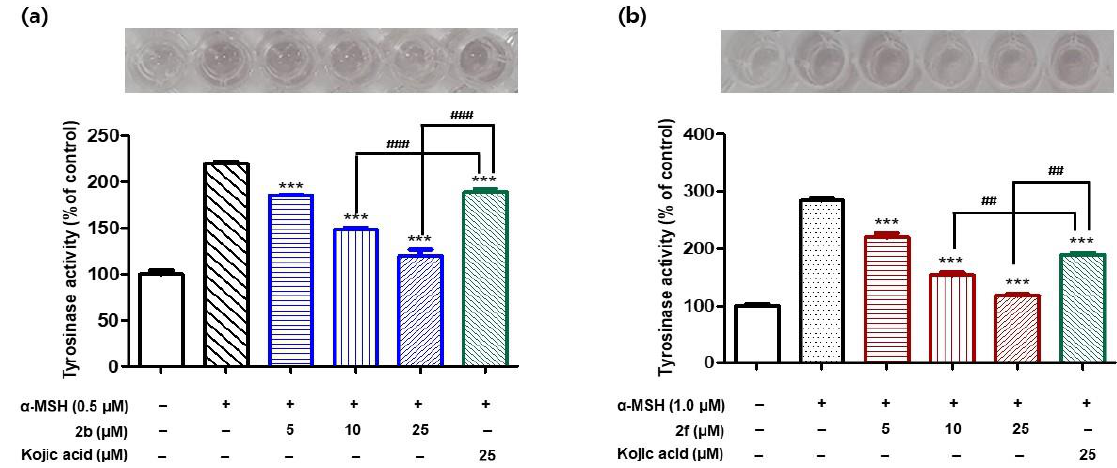
Figure 9. The inhibitory effects of compounds 2b ( a ) and 2f ( b ) on tyrosinase in B16F10 melanoma cells stimulated with α -MSH (0.5 µ M for 2b and 1.0 µ M for 2f ). Kojic acid was used as a positive control. B16F10 cells were treated with 5, 10, or 25 µ M of 2b or 2f or 25 µ M of kojic acid. Symbols * and # indicate significant differences between columns: *** p < 0.001 for α -MSH stimulated controls versus α -MSH stimulated and 2b , 2f , or kojic acid treated cells; ## p < 0.01 and ### p < 0.001 for compounds 2b and 2f , respectively, versus kojic acid. Bars represent standard errors.